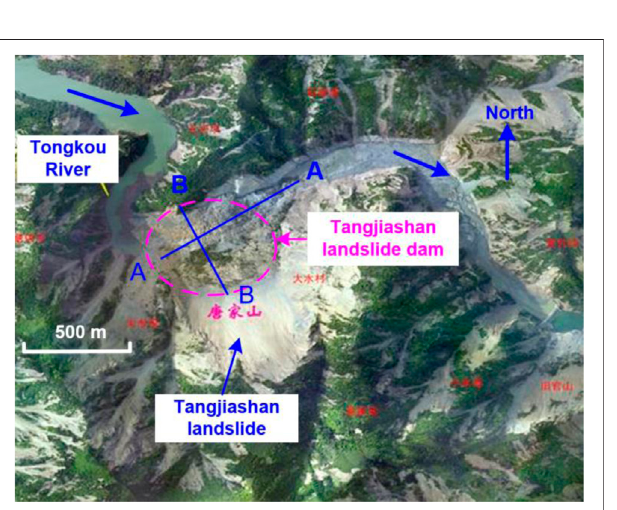
FIGURE 6 | The aerial photograph of the Tangjiashan landslide dam (Modi fi ed from Shi et al., 2015).